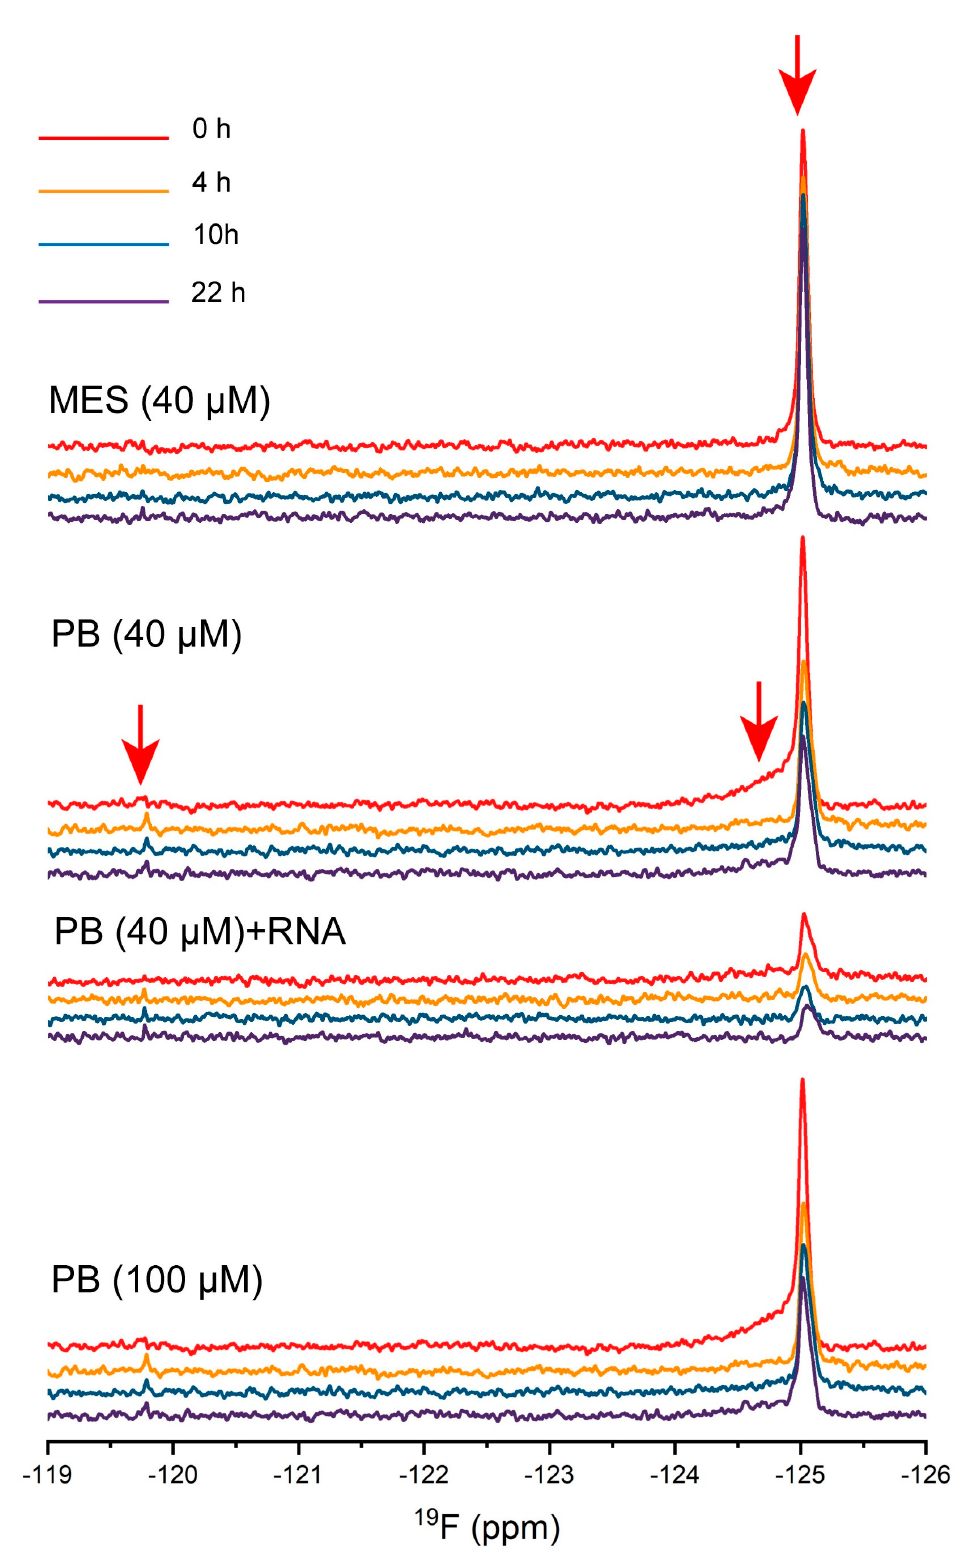
Figure 7. The dynamic changes of the protein molecules probed by 19 F NMR. Time course spectra of 40 µ M protein in pH 5.5, 20 mM MES buffer, 40 µ M protein in pH 6.0, 10 mM PB buffer, 40 µ M protein with 20 ng/ µ L in pH 6.0, 10 mM PB buffer, and 100 µ M protein in pH 6.0, 10 mM PB buffer are shown. Spectra obtained at ~30 min (labeled as 0 h, in red), 4 h (in orange), 10 h (in blue), and 22 h (in purple) from the sample preparation. The temperature was 25 °C.